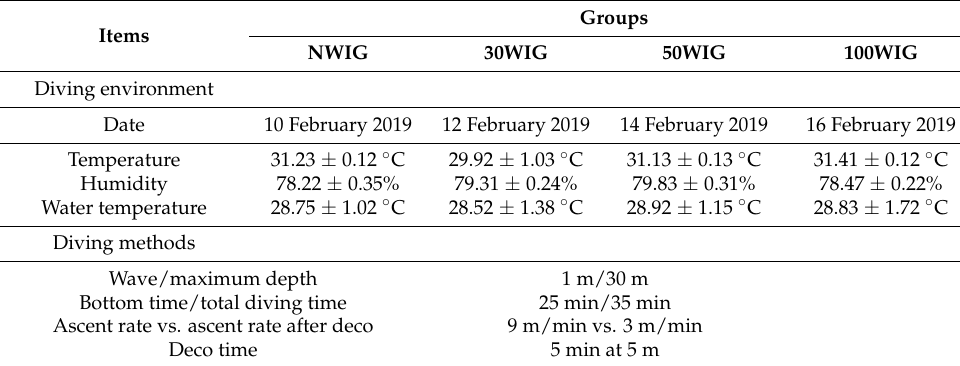
Table 1. Diving environment and